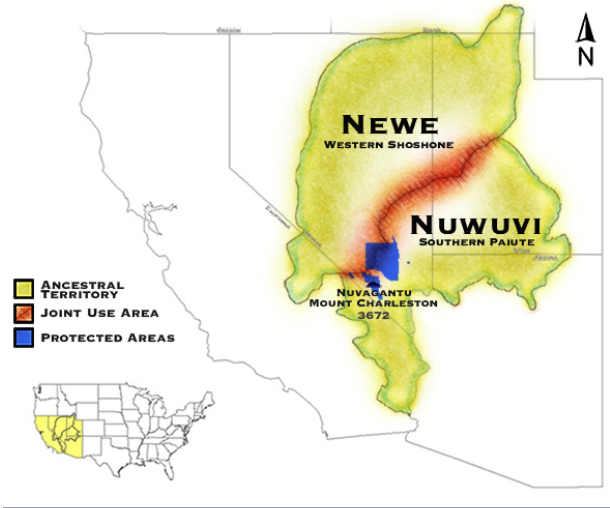
Fig. 4 . Newe (Western Shoshone) and Nuwuvi (Southern Paiute) ancestral territory and participating protected areas. All ancestral territory boundaries are approximate. Current reservations and communities represent a fraction of the ancestral territory (see Spoon and Arnold 2012). Participating protected areas include the Spring Mountains National Recreation Area (SMNRA) and the Desert National Wildlife Refuge Complex (DNWRC). Adapted from Kelly and Fowler 1986, Thomas et al.